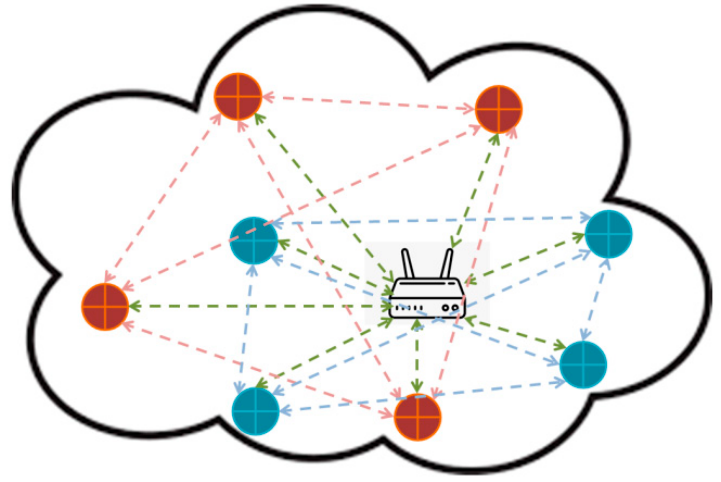
Figure 3. Wireless Sensor Networks.